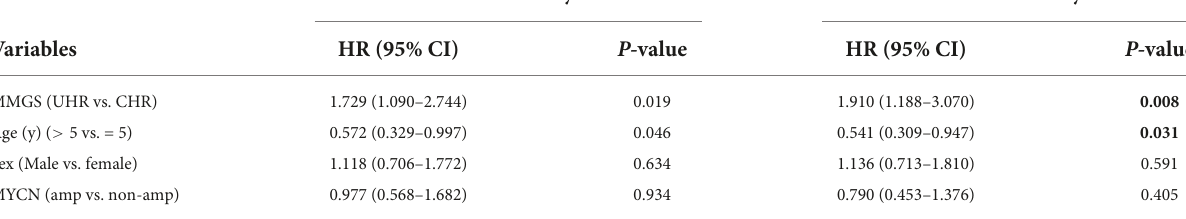
TABLE 2 Univariate and multivariate analyses of MMGS model in the TARGET HRNB cohort. Univariate analysis Multivariate